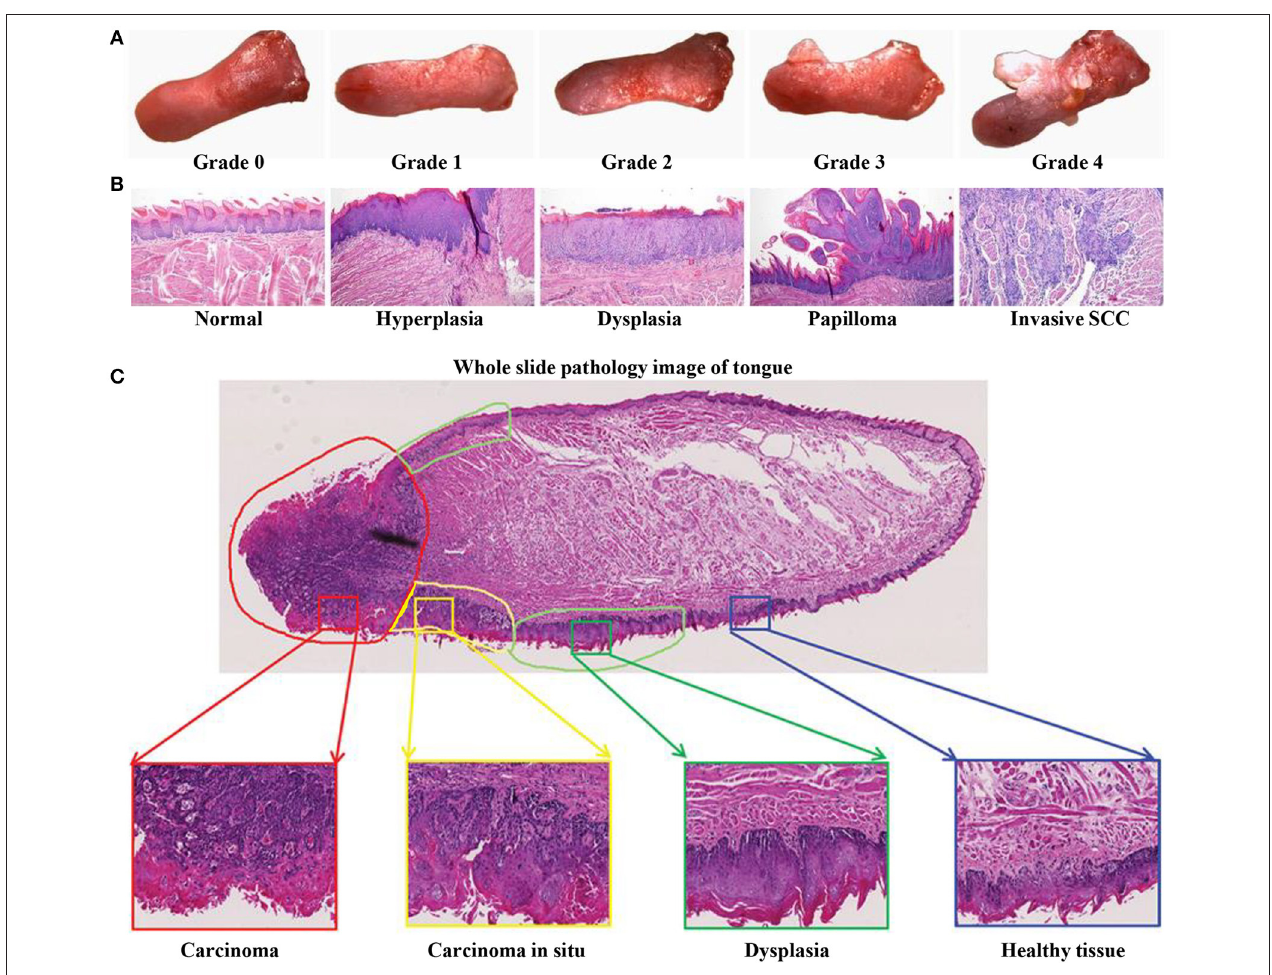
FIGURE 3 | 4NQO-induced OSCC mouse model. (A–C) Representative gross morphology and pathological stages of the tongue from 4NQO-induced mice. (A) The gross tongue lesion grading system (8 × ), and the severity of the lesions gradually increased from 0 to 4. (B) Representative pathological stages of tongue lesions. (A,B) Reproduced and modified with permission (59). Copyright © 2014, National Academy of Sciences. (C) A whole slice image of tongue specimen contains tongue lesions of dysplasia, carcinoma in situ , and carcinoma. Reproduced and modified with permission ( 60). Copyright © 2017, Wiley Online Library